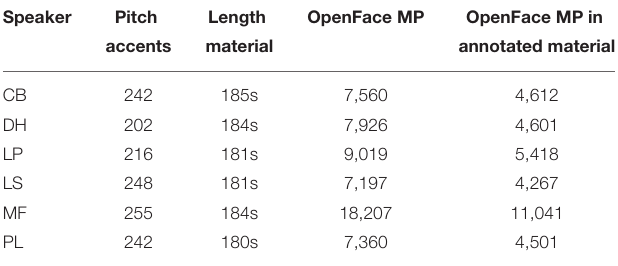
the number of pitch accents and the length of DIMA-annotated material per speaker as well as the number of measuring points ( = MP) of the OpenFace analysis both for the full video (after the exclusion of frames because of measuring issues or low confidence, see description above) and for the length of the annotated